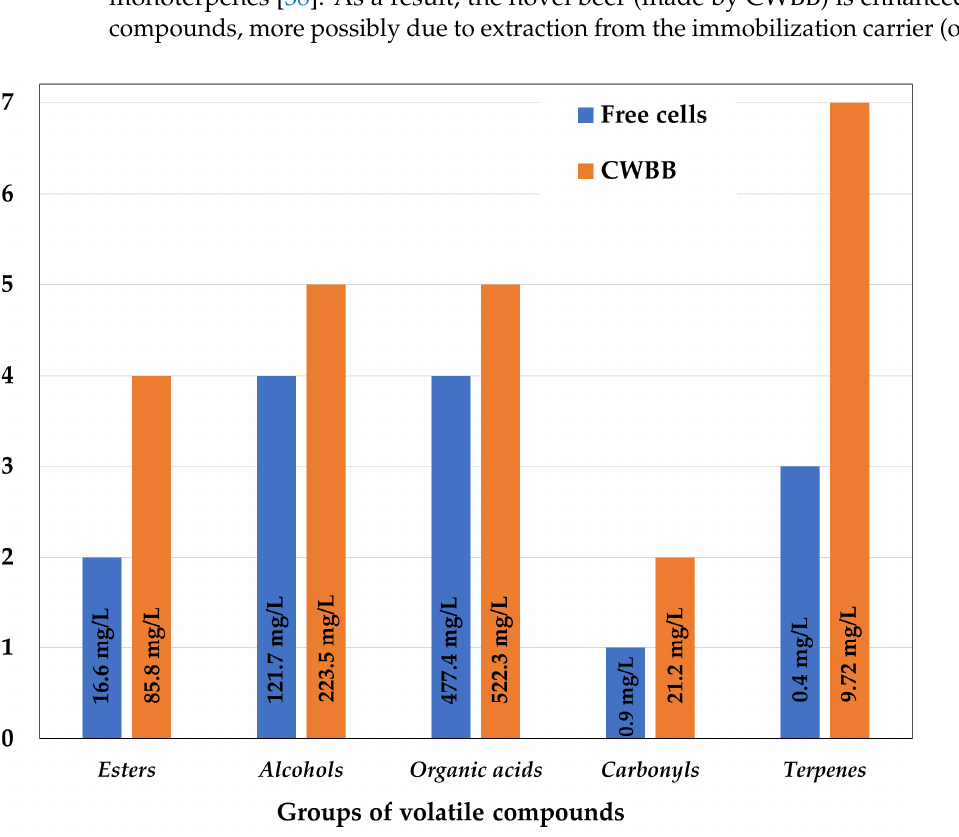
Table 2. Volatile compounds detected in the beers brewed at 10 °C using the CWBB or free yeast cells.